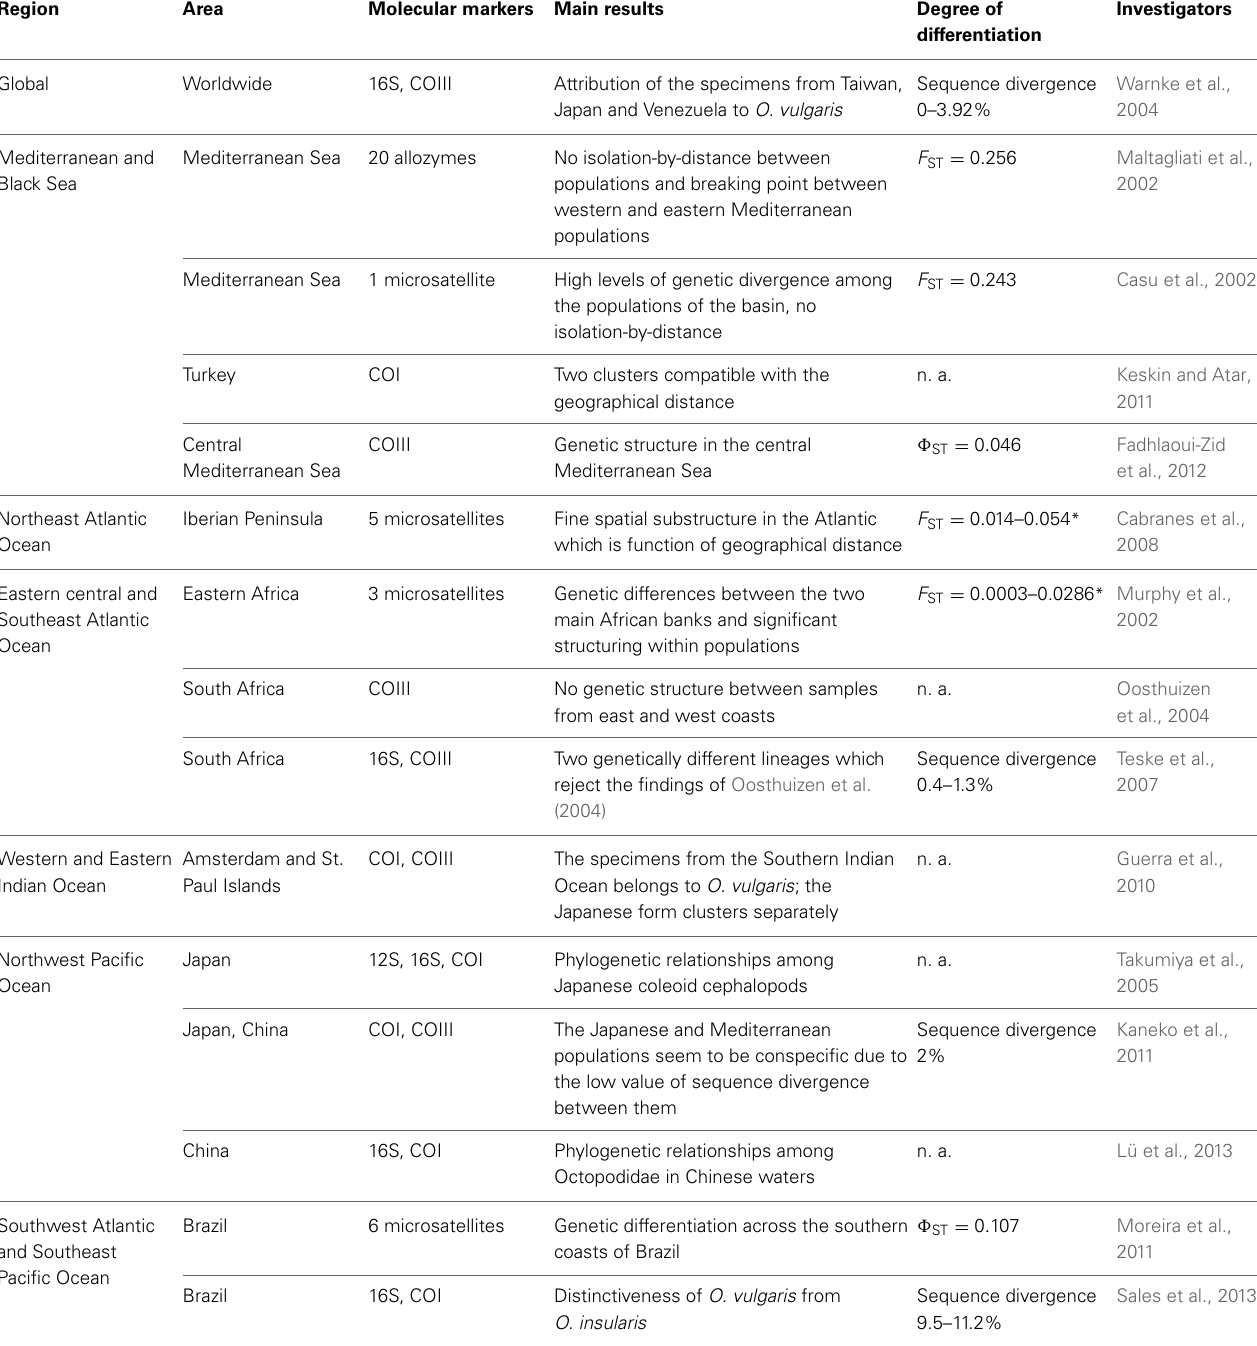
Table 1 | Resume of the main genetic studies on population structure, phylogeography and phylogenetic relationships in O. vulgaris on a global